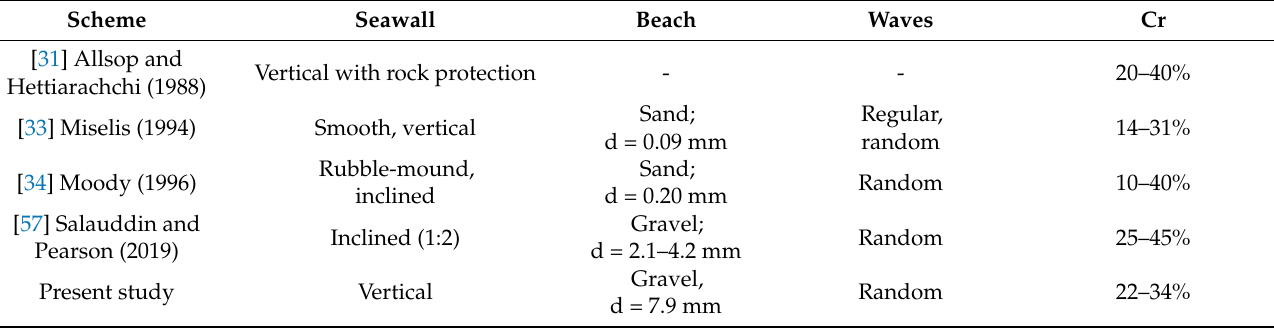
Table 2. Documented reflection coefficients C r for seawalls on